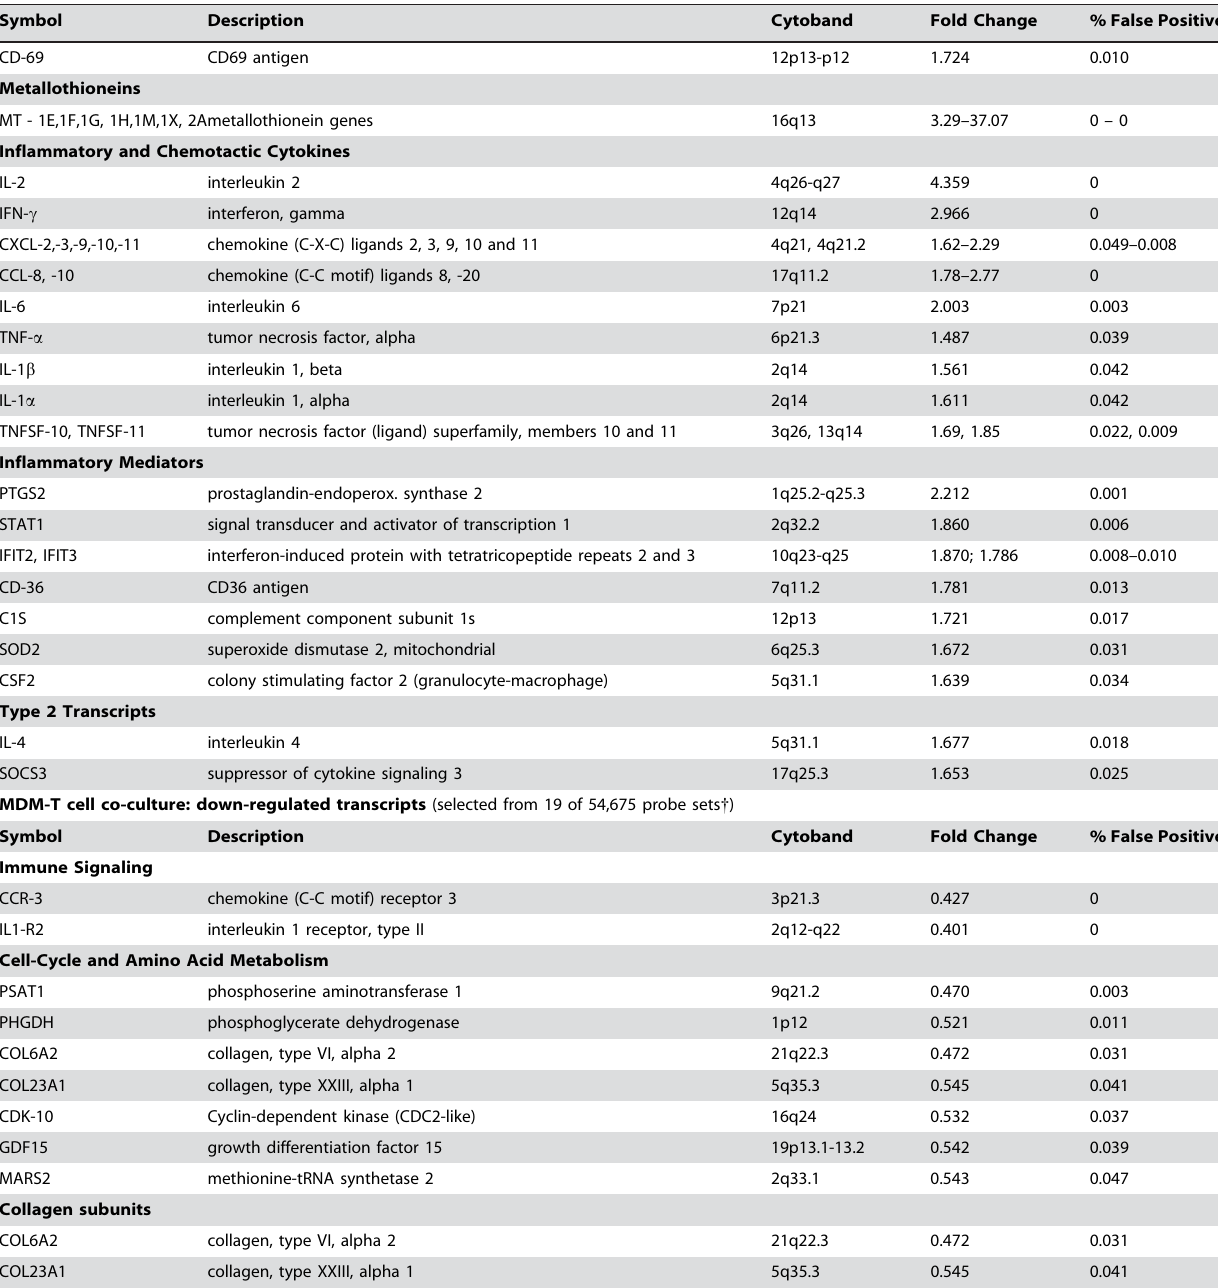
MDM-T cell co-cultures: up-regulated transcripts (selected from 116 of 54,675 probe sets {